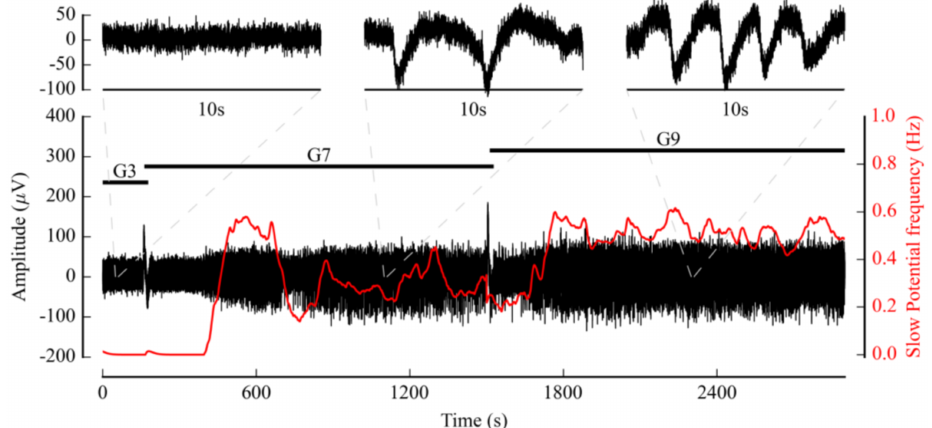
Figure 12. Raw signal (black) and Slow Potential (SPs) frequency measurements (red) on a mouse islet culture, using a Qwane MEA with microfluidic features. Zoom on three representative samples of the measured biosignal to provide a clearer illustration of changes in measured activity. Experimental protocol is described with the “G3”, “G7”, and “G9” labels, indicating changes in glucose concentrations in